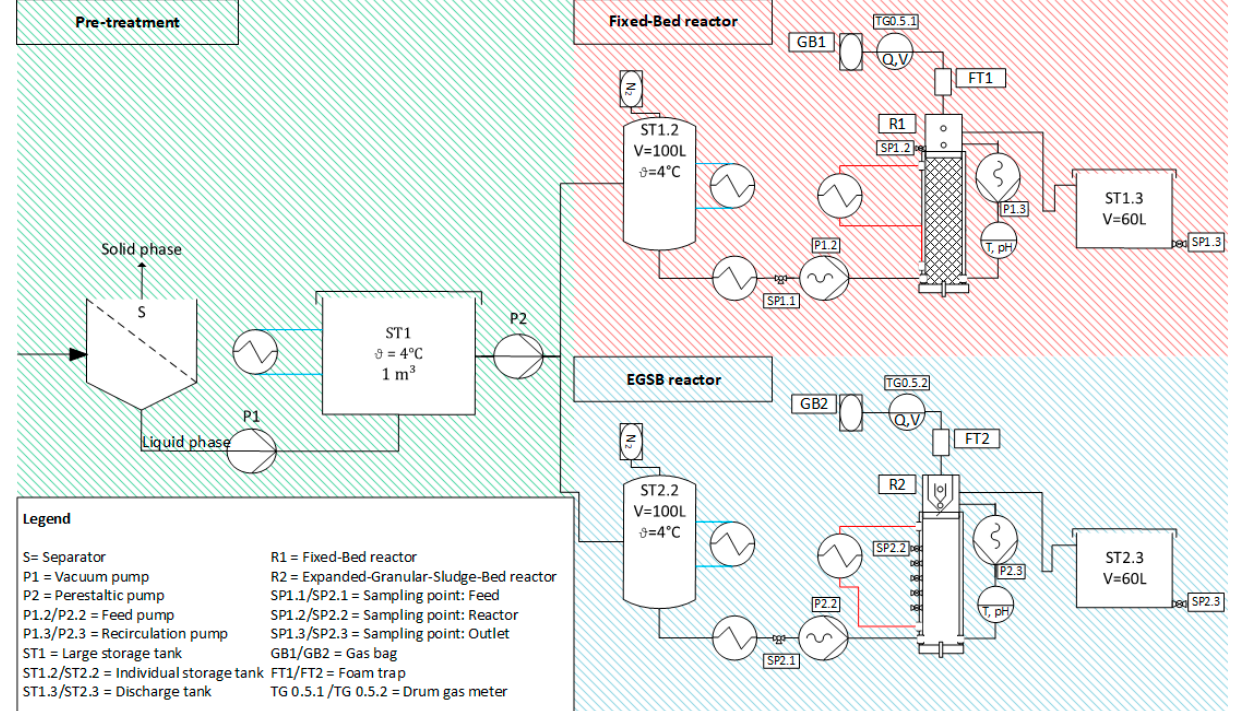
Figure 1. Schematic of the experimental setup.